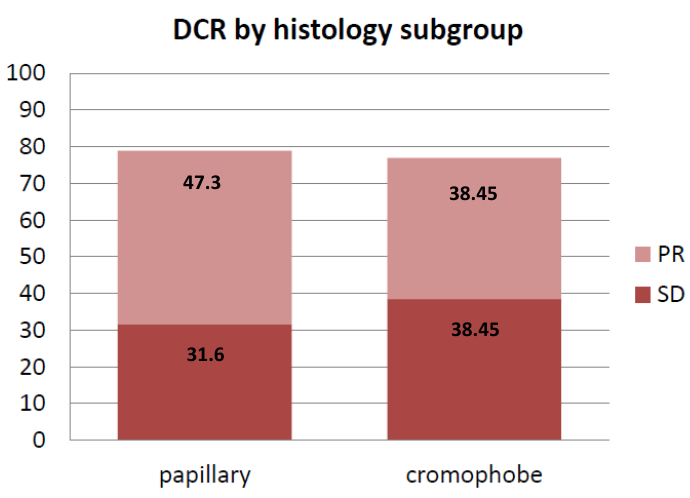
Figure 3. DCR according to histology subgroup.